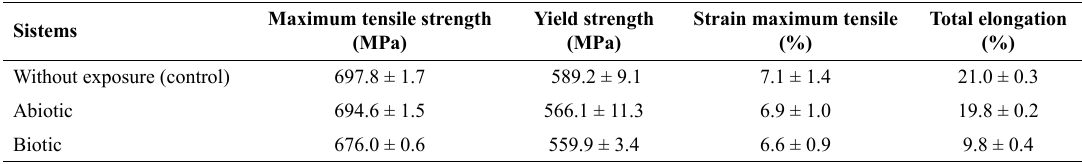
Table 4. Mean of the results obtained in the tensile tests.